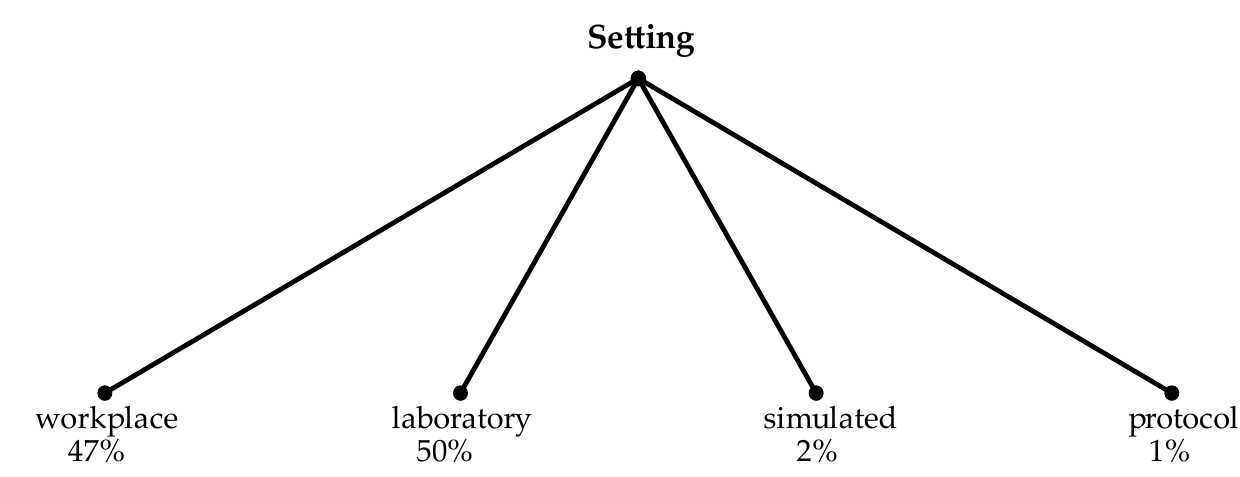
Figure 3. Distribution of settings in the screened articles.